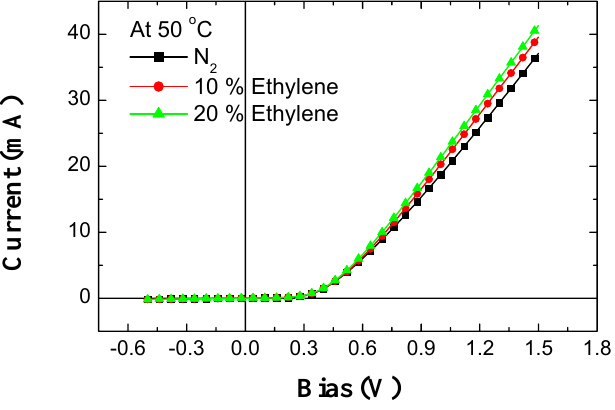
Figure 19. I-V characteristics at 50 °C (top) or 150 °C (bottom) of Pt/ZnO diodes measured in different